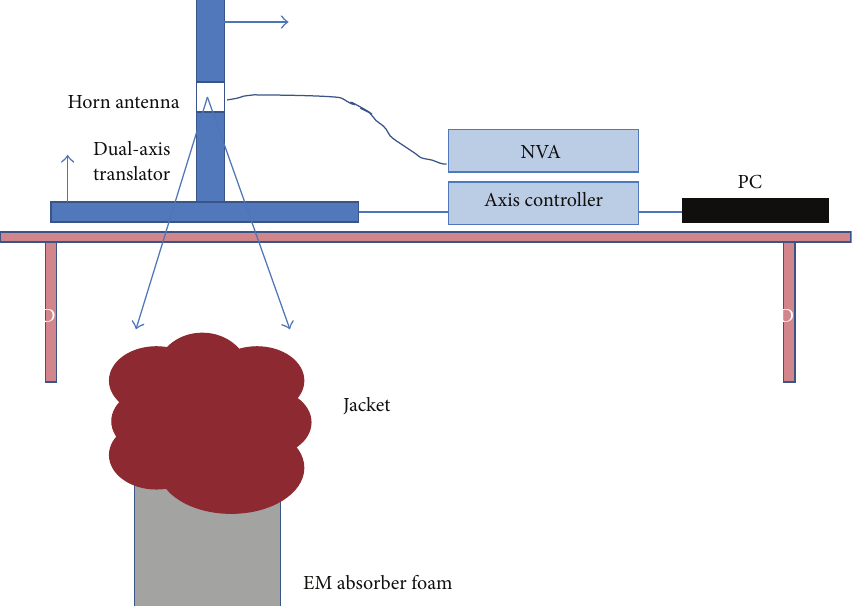
Figure 5: Schematic diagram of the imaging tool in